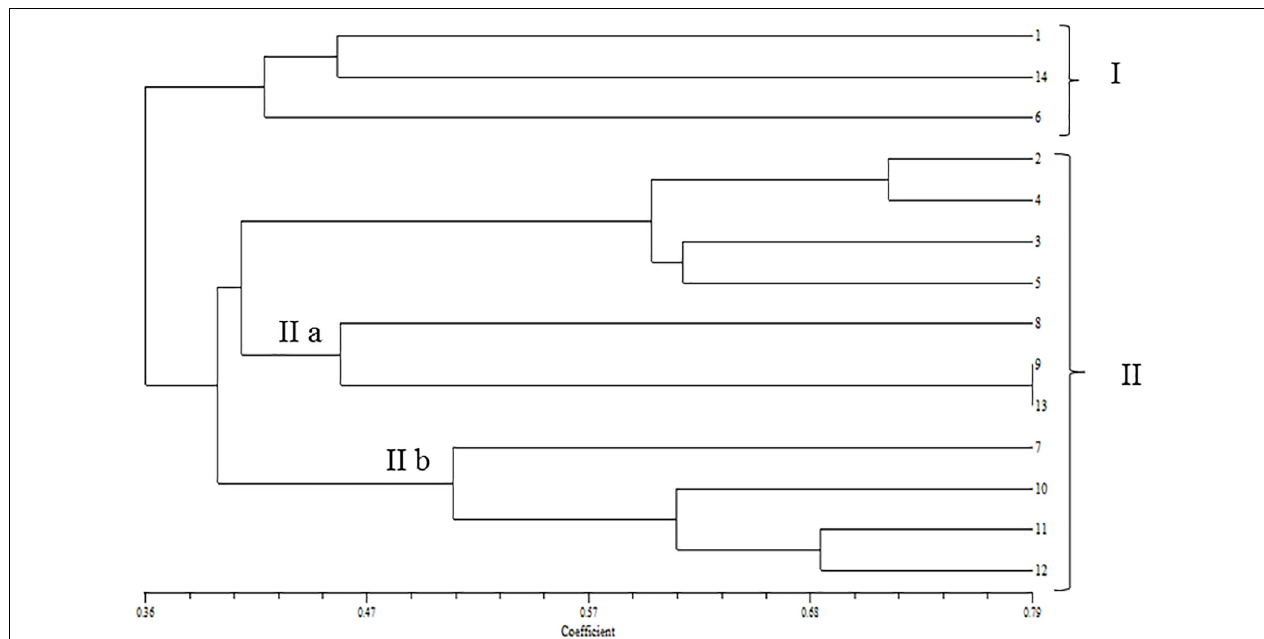
FIGURE 4 | Dendrogram of UPGMA cluster analysis constructed by using DICE similarity coefficients calculated for the Fusarium oxysporum strains based on UBC 855; UBC 856; ISSR 9 and ISSR 10. (1) TOFOL-IHBT; (2) TOFU-2- SOGHI; (3) TOFU-3 B.GHAT; (4) TOFU-IHBT; (5) TOXX- POTI; (6) TOXX-POT2; (7) TOFU-KOTBEJA; (8) TOFOL-CBE; (9) TOFS-CPCT2; (10) TOFS-3-CPCT; (11) TOFU-MM; (12) TOFS-MU; (13) TOFU-4CPCT; (14)